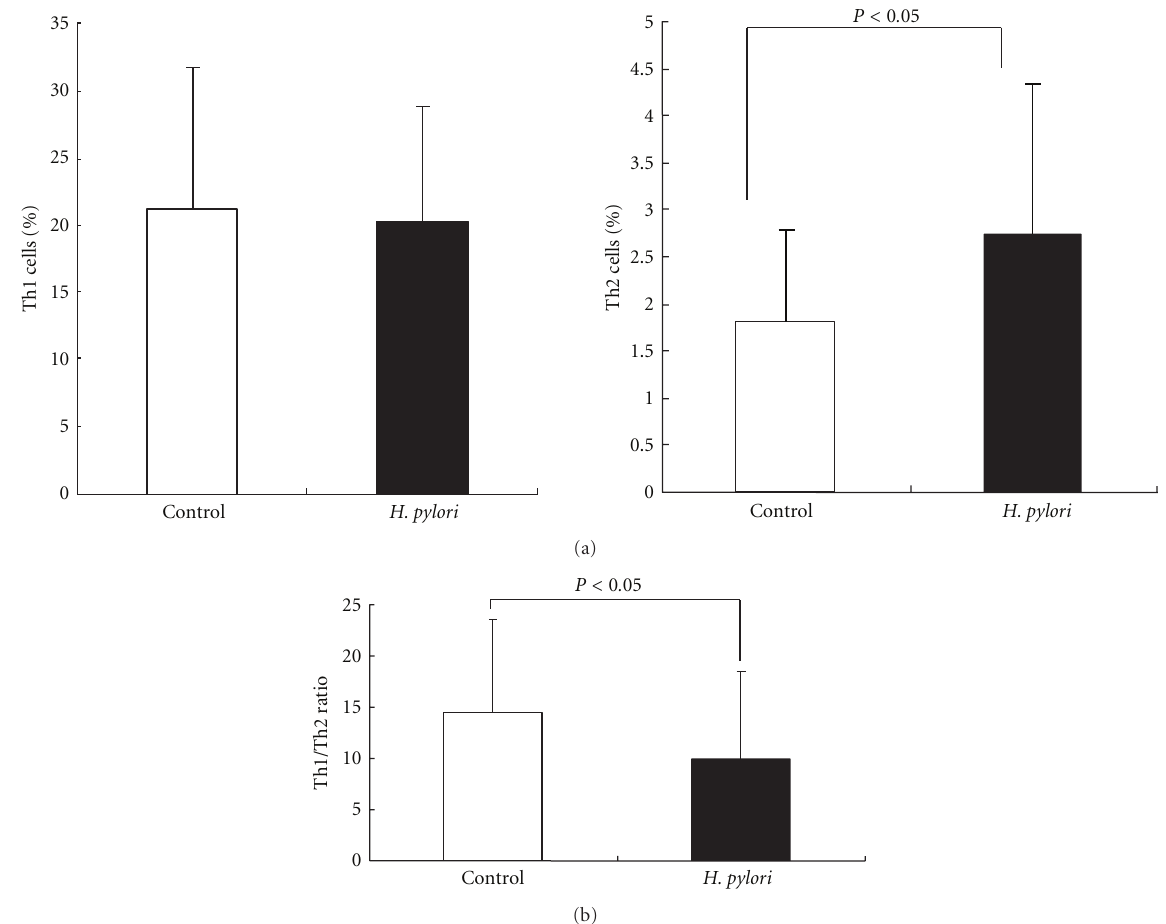
Figure 2: (a) The percentage of Th1 cells and Th2 cells. Left and right figures show the percentage of Th1 and Th2 cells, respectively. White columns represent the data of normal subjects, and black columns represent the data of H. pylori- infected patients. Data are given as mean ± SD. There was no significant di ff erence in the percentage of Th1 cells in H. pylori- infected patients (mean ± SD; 20 . 2 ± 8 . 6%) and control subjects (mean ± SD; 21 . 2 ± 10 . 6%). However, the percentage of Th2 cells in H. pylori -infected patients (mean ± SD; 2 . 8 ± 1 . 6%) was significantly higher than in control subjects (mean ± SD; 1 . 8 ± 1 . 0%), ( P < 0 . 05). (b) Comparison of Th1/Th2 ratio. White columns represent the data of normal subjects, and black columns represent the data of H. pylori- infected patients. Data are given as mean ± SD. The Th1/Th2 ratio was significantly lower in H. pylori -infected patients (mean ± SD; 10 . 0 ± 8 . 5) compared to control subjects (mean ± SD; 14 . 5 ± 9 . 0) ( P < 0 .